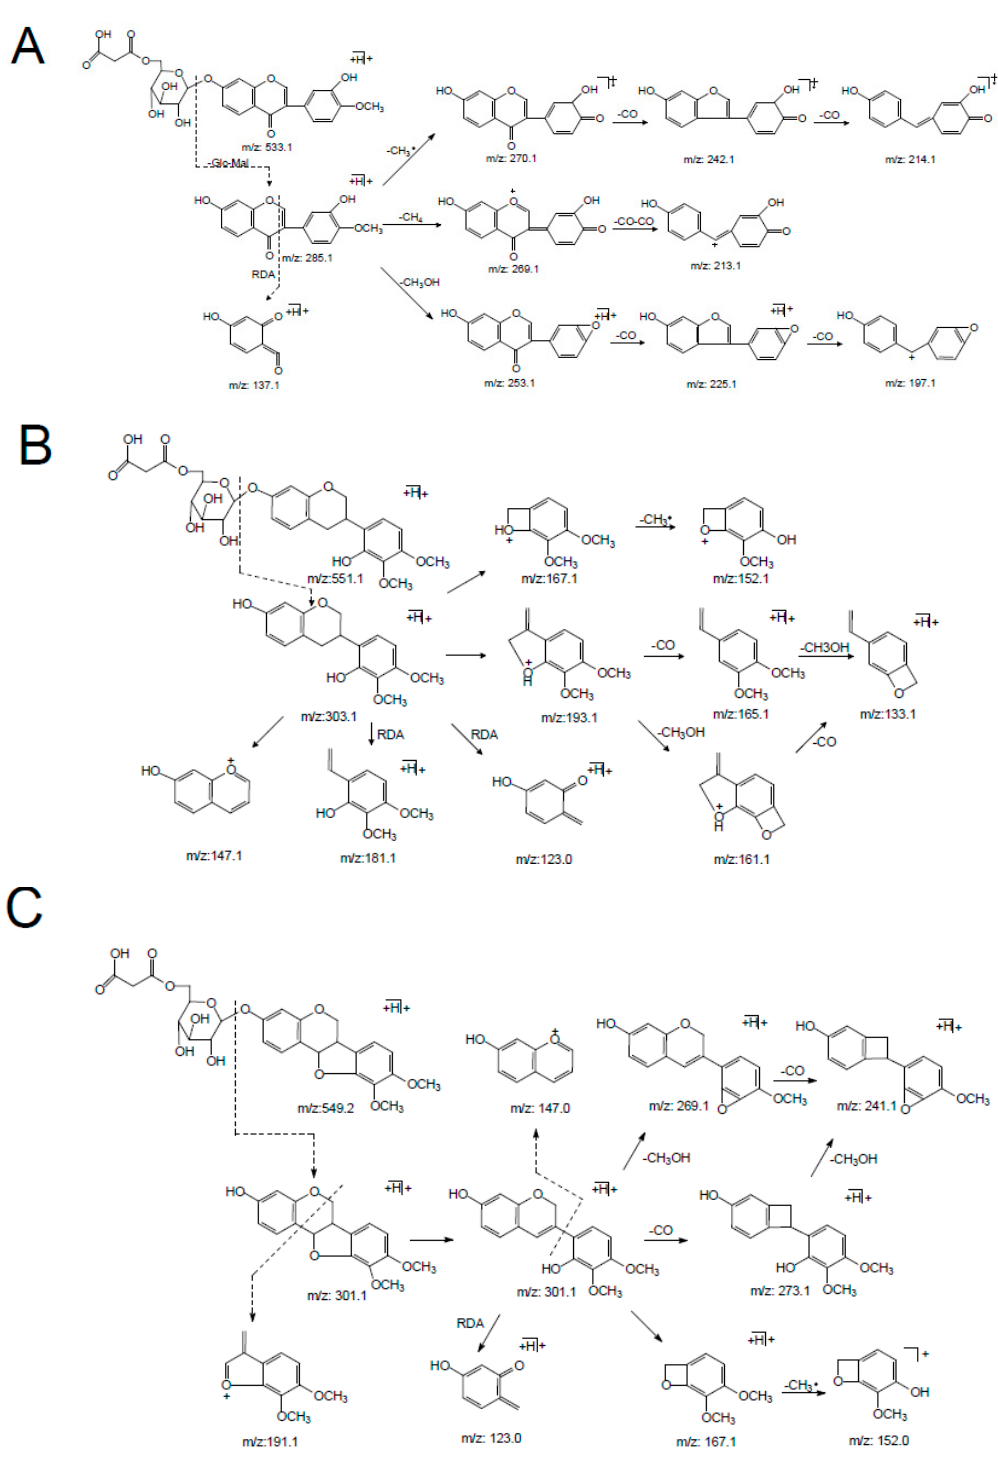
Figure 4. The main MS n fragmentation pathway for three malonyl isoflavonoid glycosides from Astragali Radix . ( A ) Calycosin-7-O-Glc-6 ′′ -O-Mal. ( B ) Astraisoflavanglycoside-6 ′′ -O-Mal. ( C ) Astraperocarpan-3-O-Glc-6 ′